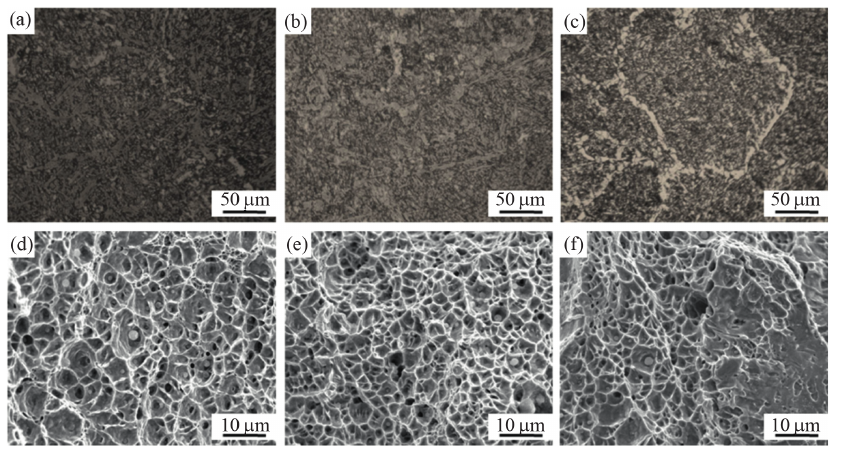
Figure 6: Microstructure and fracture of welding heat-affected zone: (a, d) coated with boron oxide; (b, e) coated with chromium oxide; and (c) conventional